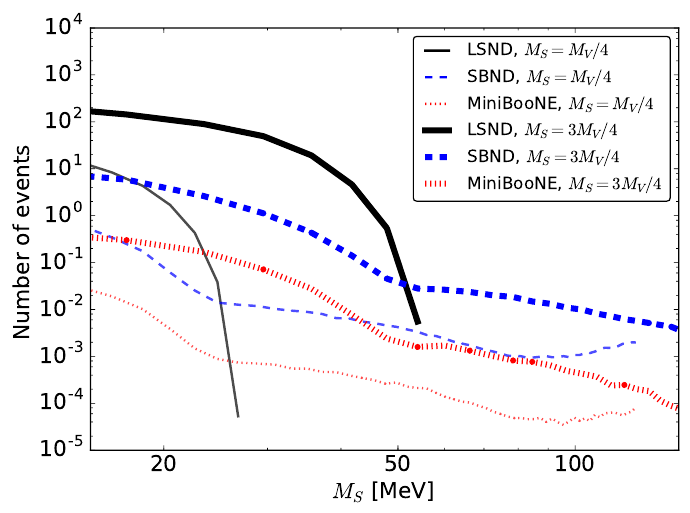
Figure 5. Number of events expected at LSND, miniBooNE and SBND experiments as a function of dark Higgs boson mass M S . We show two mass ratios: M S = M V = 4 (thin lines) and M S = 3 = 4 M V (thick lines). We have chosen the couplings to be " = 0 : 001 and (cid:11) D = (cid:11) em